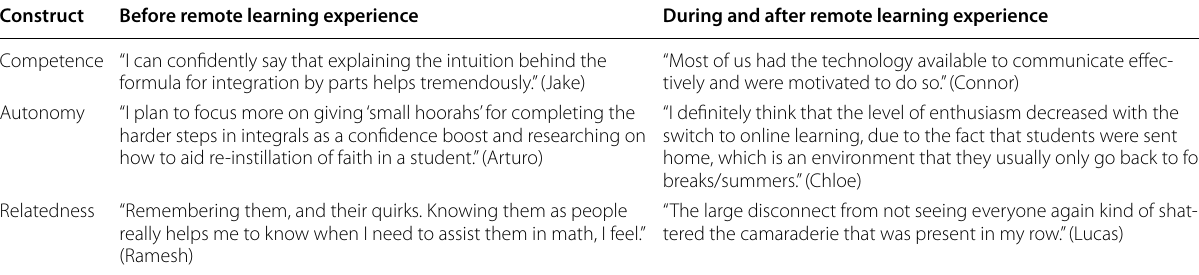
Table 2 Supporting quotations from LAs’ reflections to the three constructs of SDT before, during and after the remote learning